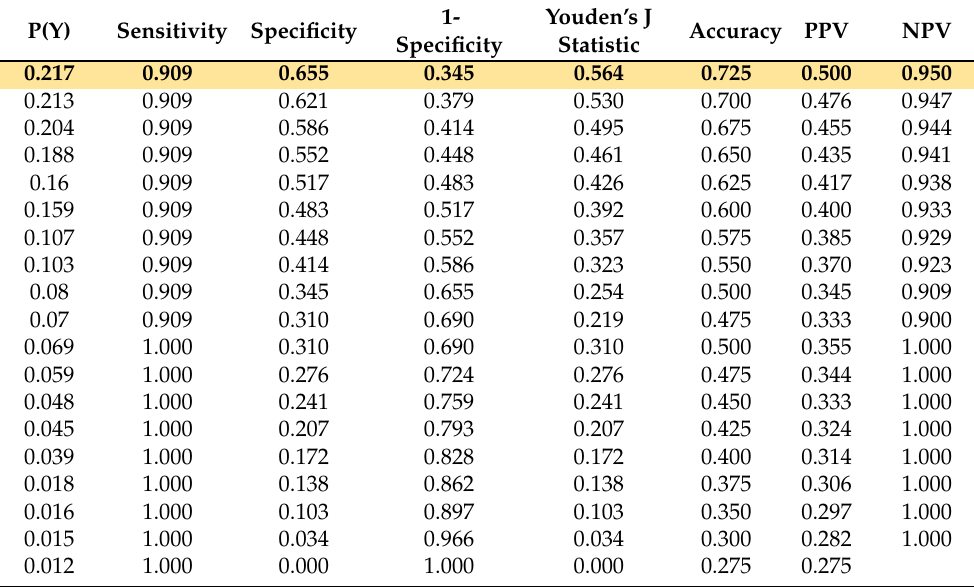
Table A4. Cont. Metrics Regarding Logistic Logistic Regression Model 1 (Table 4: Model 1)